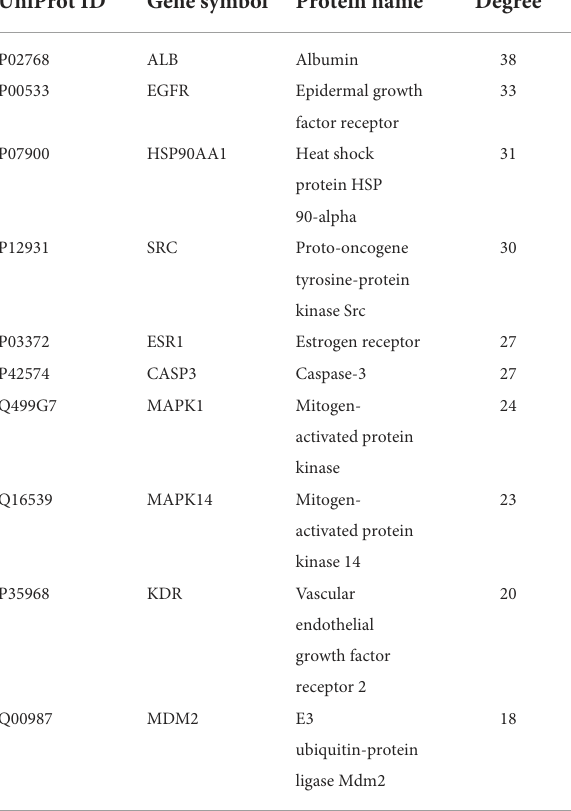
TABLE 8 Information of 10 core ingredients and target genes after drugs-ingredients-targets network analysis.